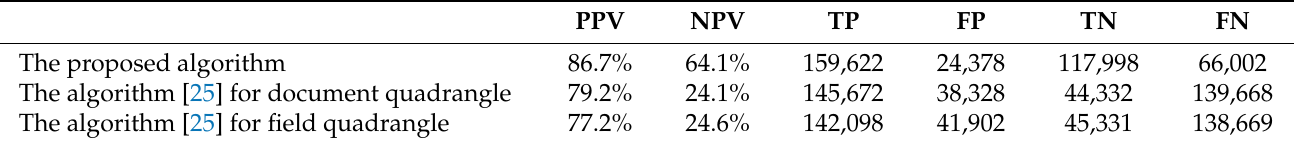
Table 1. The cumulative predictive values, positive (PPV) and negative (NPV), of the quality assessment